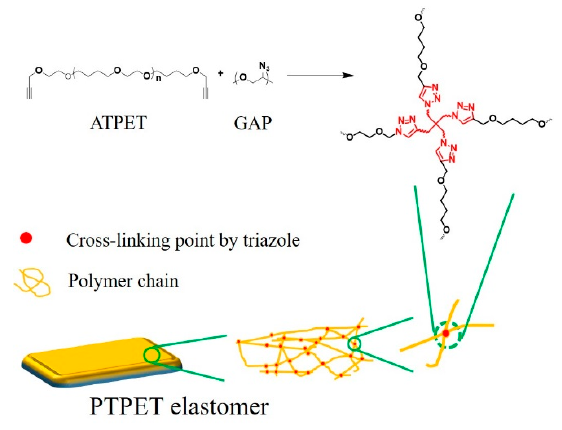
Scheme 1. Synthesis of polytriazole polyethylene oxide − tetrahydrofuran (PTPET) elastomer.